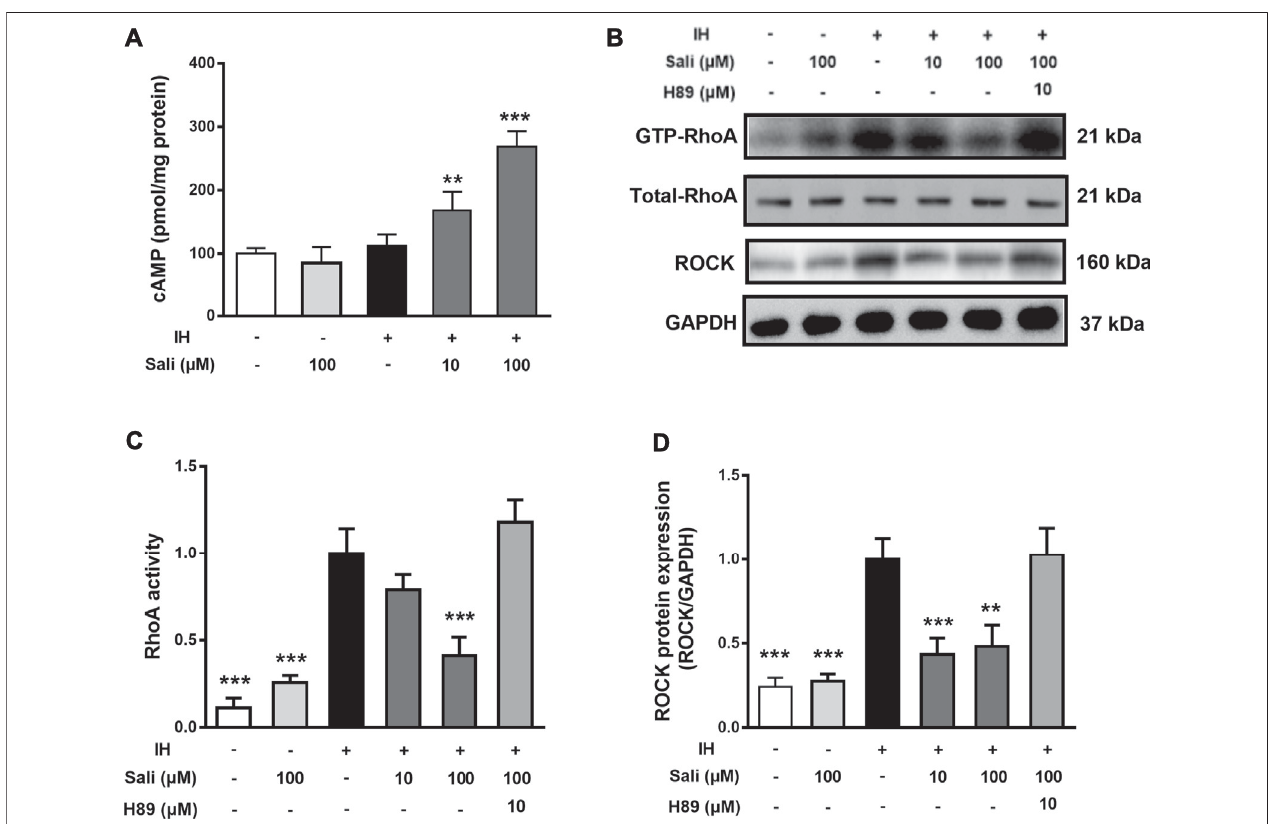
FIGURE 5 | Salidroside suppressed IH-induced elevation of RhoA activity and ROCK protein expression in HUVECs through the cAMP/PKA pathway. HUVECs werepretreated withSali(10 µMor100 µM)orthePKA inhibitor H-89for2 hbeforeexposure to72cycles ofIH (A) Intracellular cAMPlevels, aswellas (B) RhoAactivity and ROCK protein levels were measured (C – D) Relative levels of RhoA activity and ROCK protein expression were quanti fi ed by densitometry analysis. IH, intermittent hypoxia; Sali, salidroside; RhoA, ras homolog gene family member A; ROCK, Rho-associated protein kinase. All data are presented as mean ± SD. * p < 0.05 and *** p < 0.001 compared with IH group.